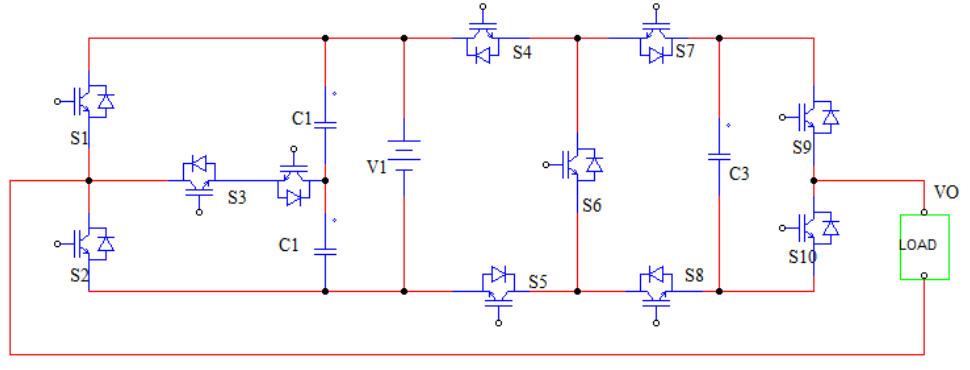
Figure 14. Ten-switch, nine-level topology [63]. Figure 15 depicts a nine-level multilevel inverter based on a T-type switched capac- itor module with a reduced number of switches (S1–S10) and a single DC source with four capacitors and two diodes